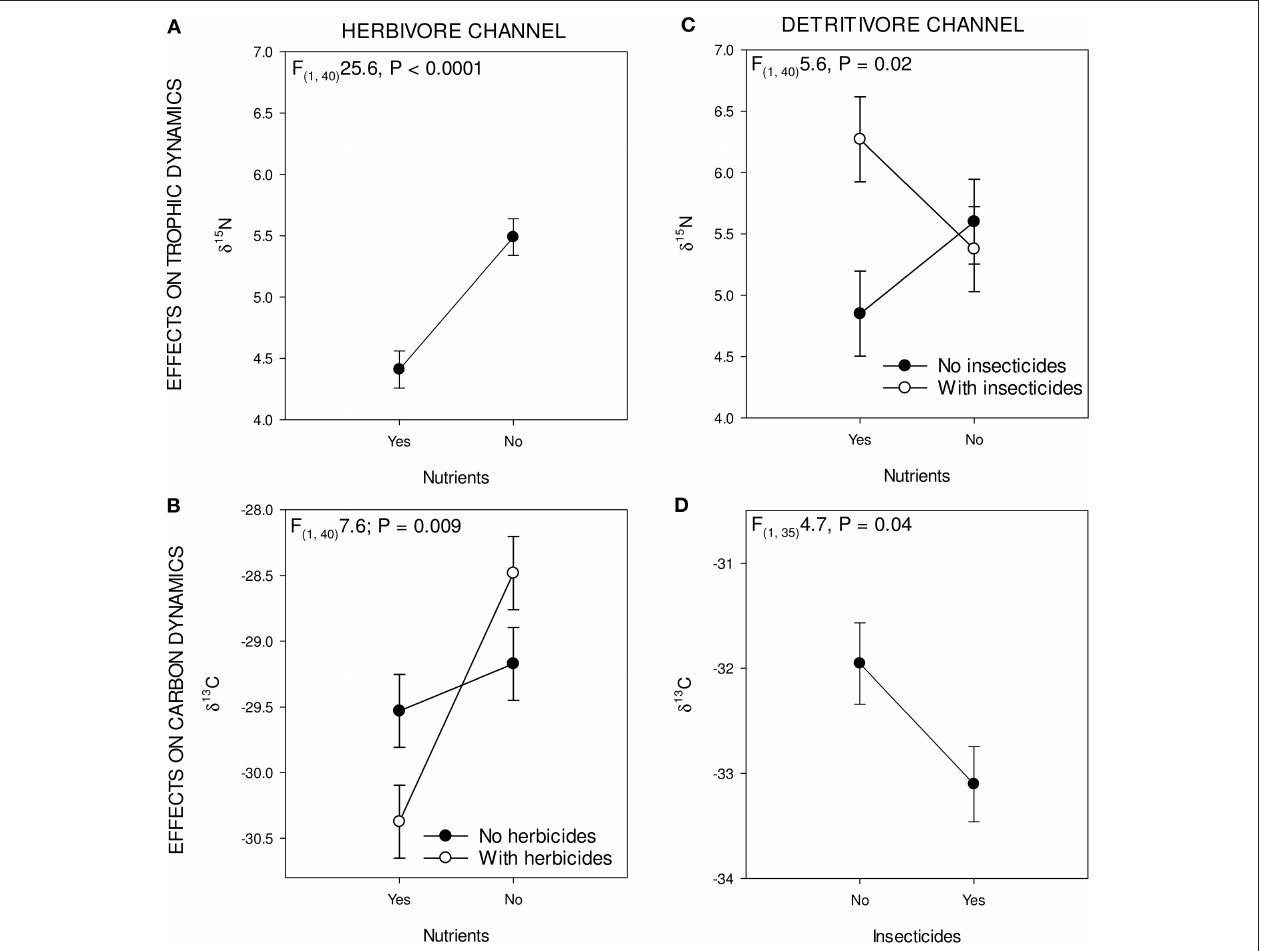
FIGURE 2 | Figure showing the significant treatment effect on the green and brown parts of the food web: upper two (A,B) showing effects of treatments on trophic level ( δ 15 N/ 14 N) and lower two (C,D) illustrate the effect on food source ( δ 13 C/ 12 C) for green and brown.